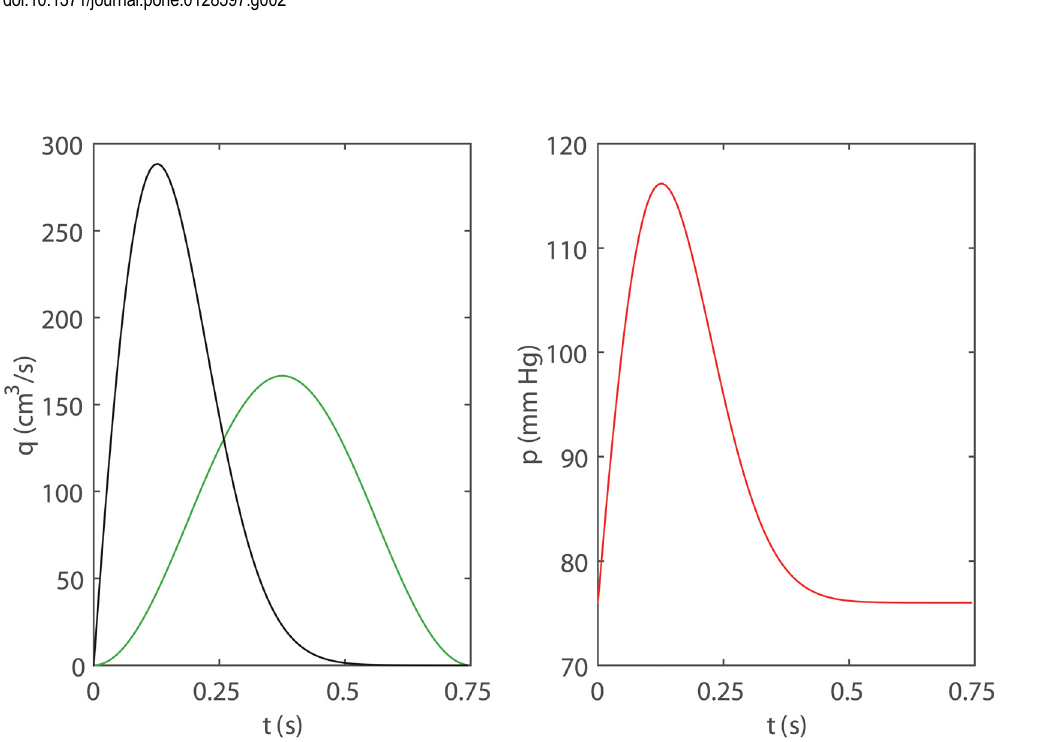
Fig 3. The three distinct inlet boundary conditions. The sinusoidal flow (Eq (27)), pulsatile flow (Eq (28)), and the pulsatile pressure (Eq (29)) inputs are represented by green, black, and red lines, respectively. The two flow inputs in the left panel are obtained with Q 0 = 83.3 cm 3 / s .